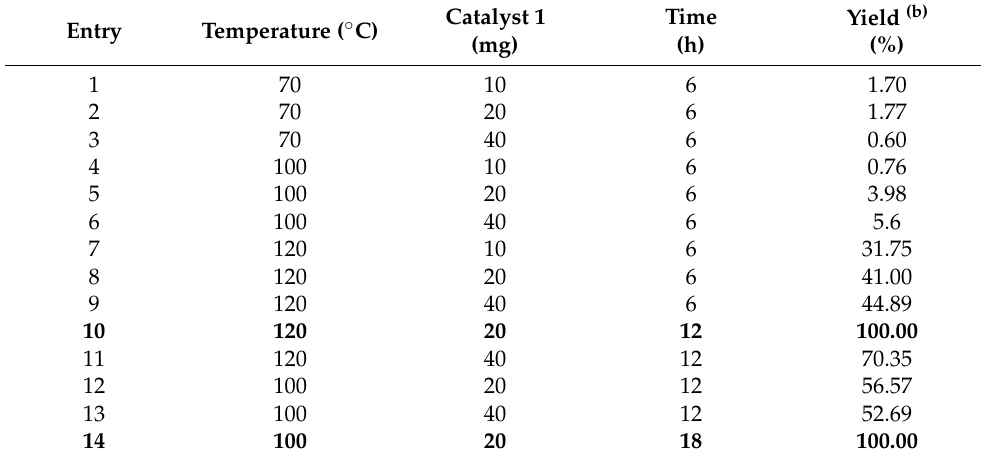
Table 2. Optimization one-by-one of transesterification parameters (a)